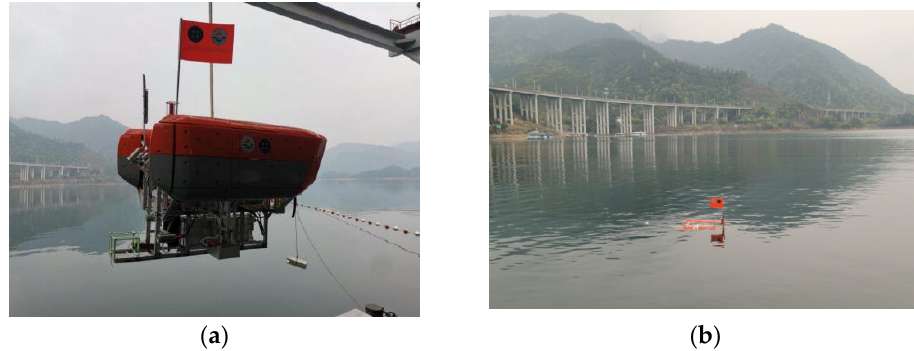
Figure 21. ( a ) Launching ARV in Qiandao Lake; ( b ) ARV cruises on the water surface.